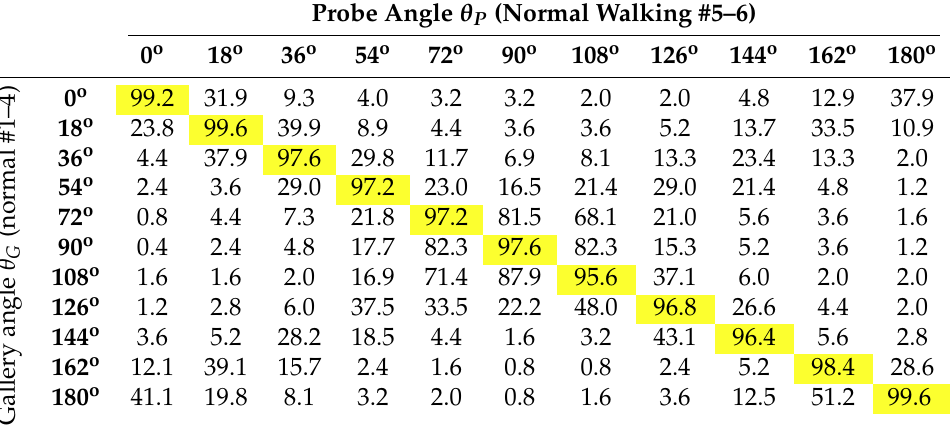
Table 2. Evaluation results reported in [15].